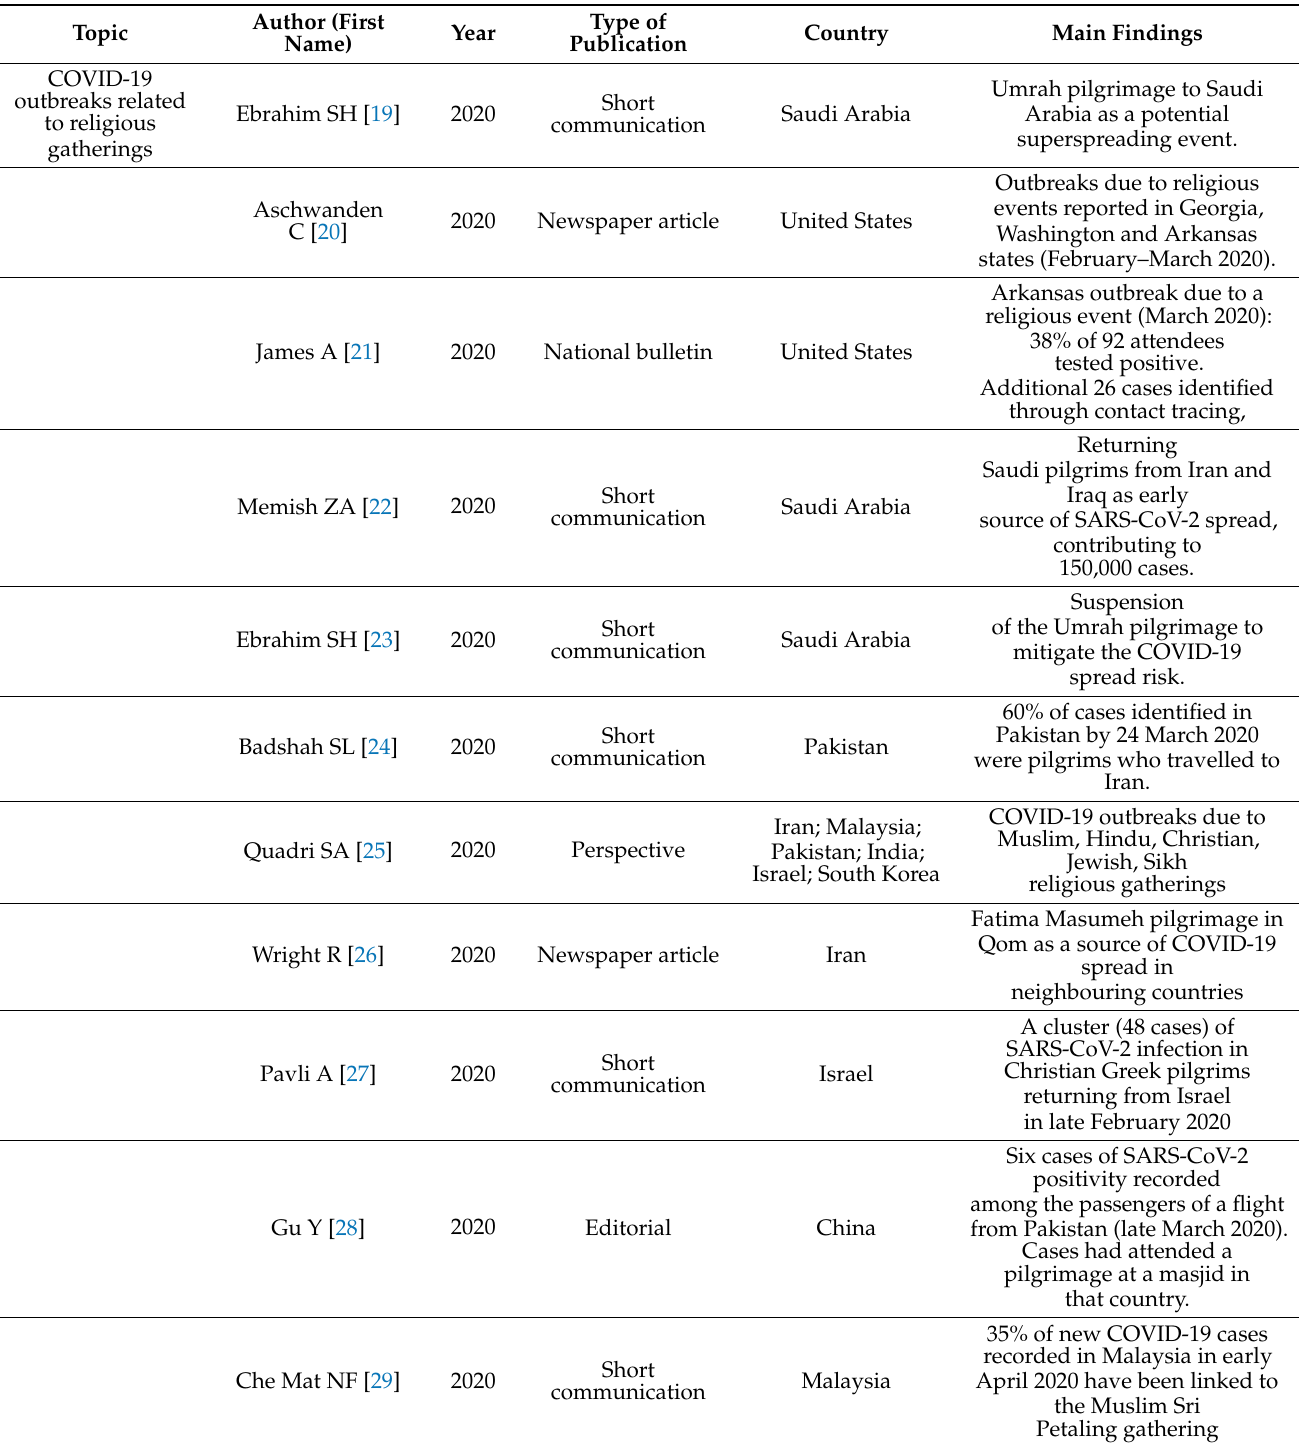
Table 1. Main topics and related references resulting from the literature